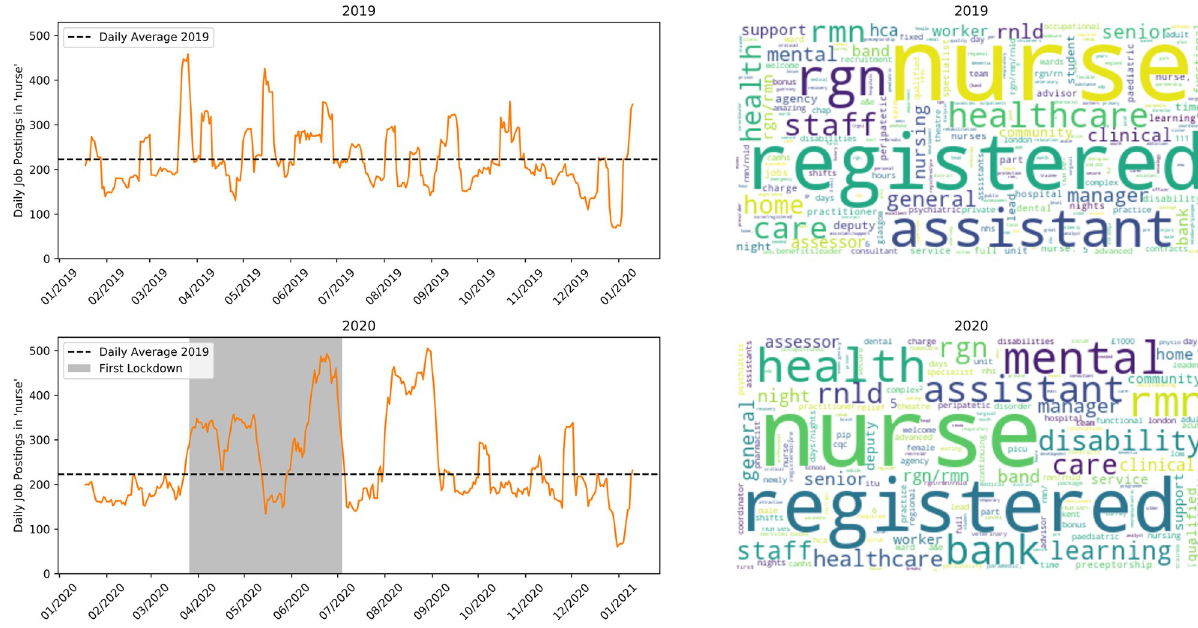
Fig 6. Jobs matching ‘nurse’. Top row is 2019, bottom is 2020.